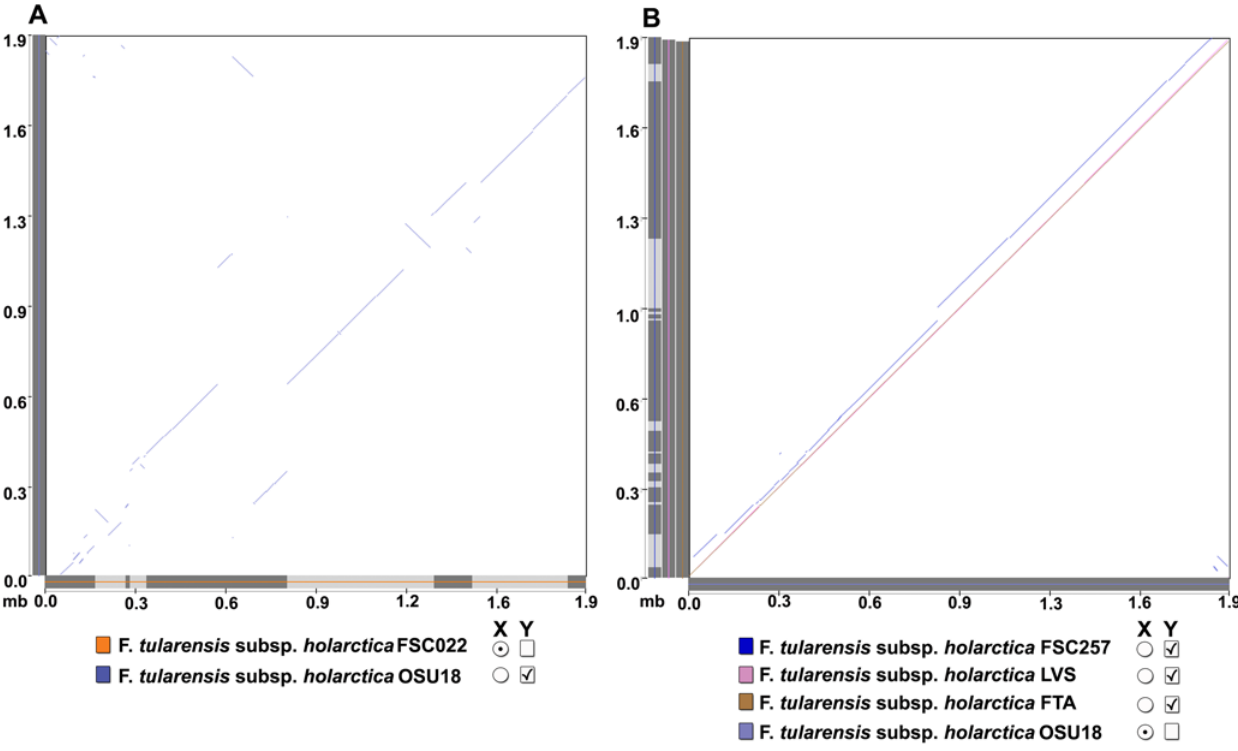
Figure 2. Dotplot comparison between the Francisellatularensis subsp. holarctica strains showing the occurrence of significant rearrangement events. Whole genome alignments and dotplot comparisons between Type B strains of Francisella : (A) F. tularensis subsp. holarctica OSU18 and F. tularensis subsp. holarctica FSC022 (reference genome) and (B) F. tularensis subsp. holarctica LVS, F. tularensis subsp. holarctica OSU18 (reference genome), F. tularensis subsp. holarctica FSC257, F. tularensis subsp. holarctica FTA. Alignments were filtered for overlap percentages greater than or equal to 90%. Dotplot (B) shows a nearly linear, overlapping alignment between all of the Type B strains of the main holarctica lineage (not all of the strains of the Type B radiation lineage are shown for clarity), with the notable exception of comparisons between the F. tularensis subsp. holarctica OSU18 and F. tularensis subsp. holarctica FSC257 strains. In contrast, numerous rearrangements are evident from comparisons between the F. tularensis subsp. holarctica FSC022 japonica strain and all of the other Type B strains of the main holarctica lineage (A) (only comparison to the F. tularensis subsp. holarctica OSU18 strain is shown here).